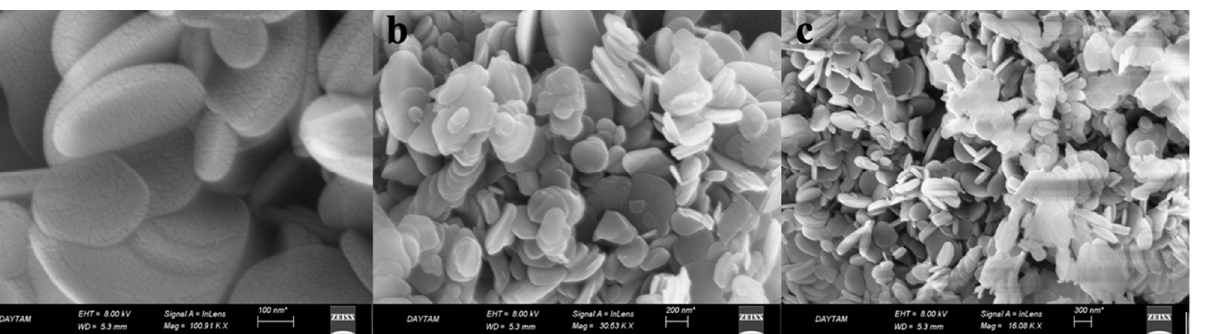
Figure 2. Images of hBN-NPs at different scales under the SEM: ( a ) 100 nm, ( b ) 200 nm, ( c ) 300 nm. A β -induced neurotoxicity potential and damage to membrane integrity were eval- uated on differentiated SH-SY5Y cells (Figure 4) by MTT and LDH assays. Treatments with 1, 5, 10 and 25 mg/L of hBN-NPs did not alter the cell viability rates as compared